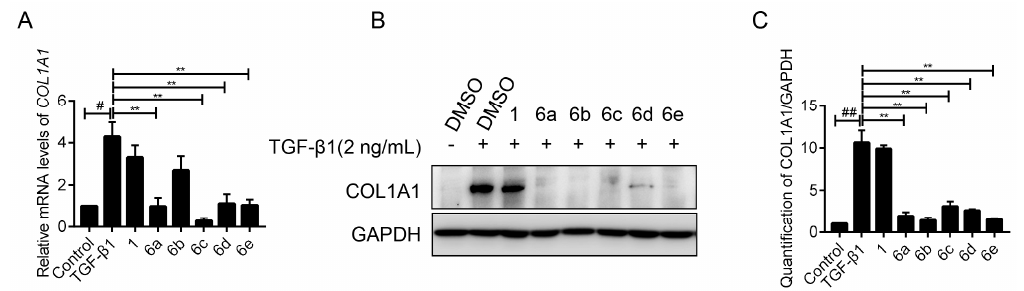
Figure 3. Inhibition e ff ect of compounds on COL1A1 expression. The mRNA level ( A ) and protein level ( B ) of COL1A1 were detected in LX-2 cells after treatment with the indicated compound (10 µ M), together with transforming growth factor-beta 1 (TGF- β 1) (2 ng / mL) for 24 h. ( C ) Quantification of COL1A1 intensity of ( B ). The mRNA / protein level was normalized against GAPDH. Data were presented as the mean ± SEM, # p < 0.05, ## p < 0.01 as compared to that of control group; ** p < 0.01 as compared to that of TGF- β 1 group.